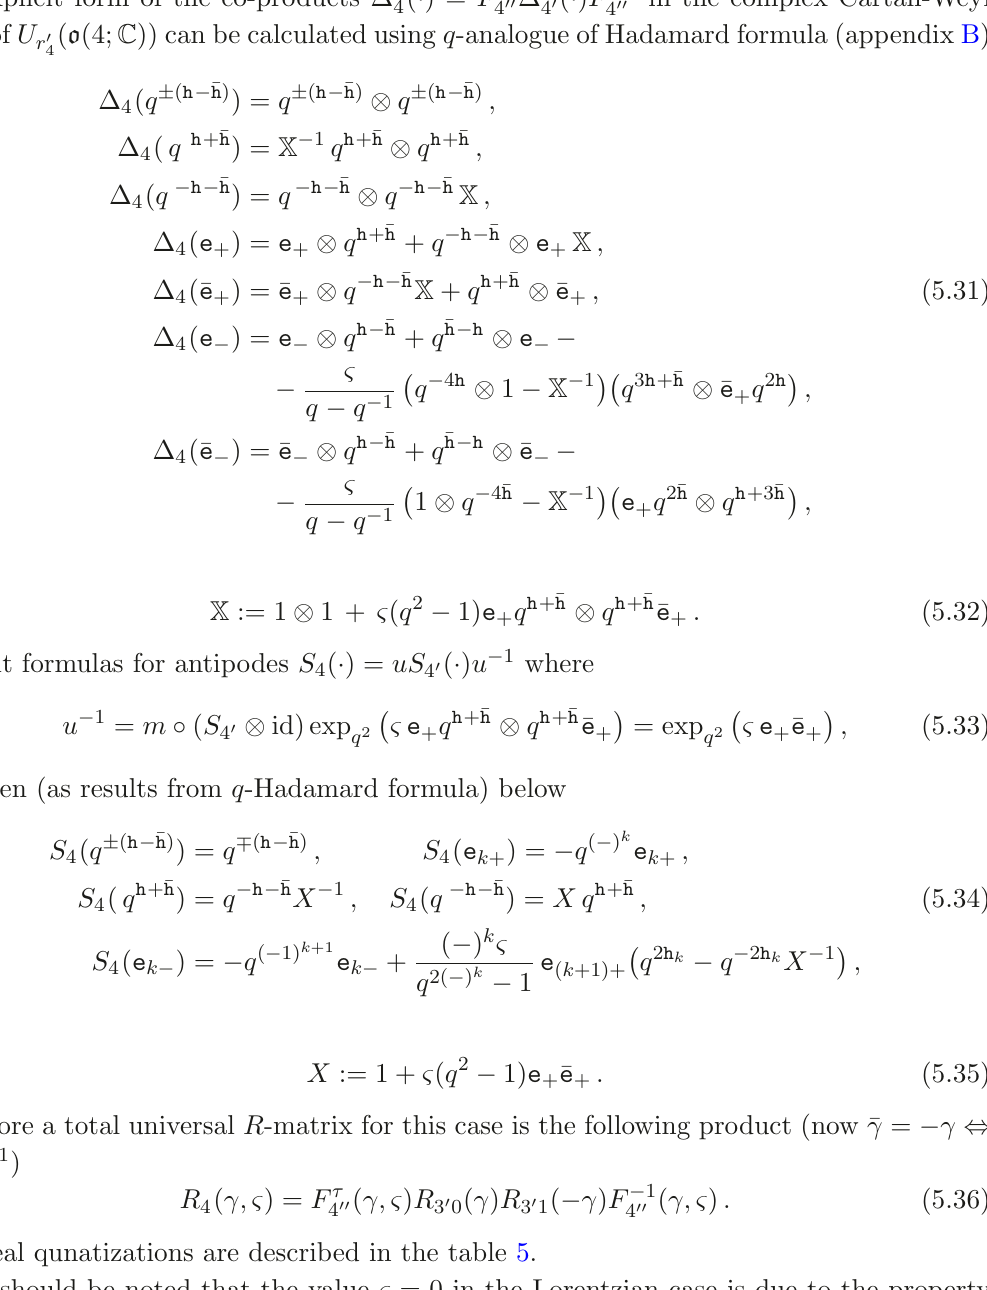
Table 5 . Real quantizations of r IV ( γ, ς ) = γ